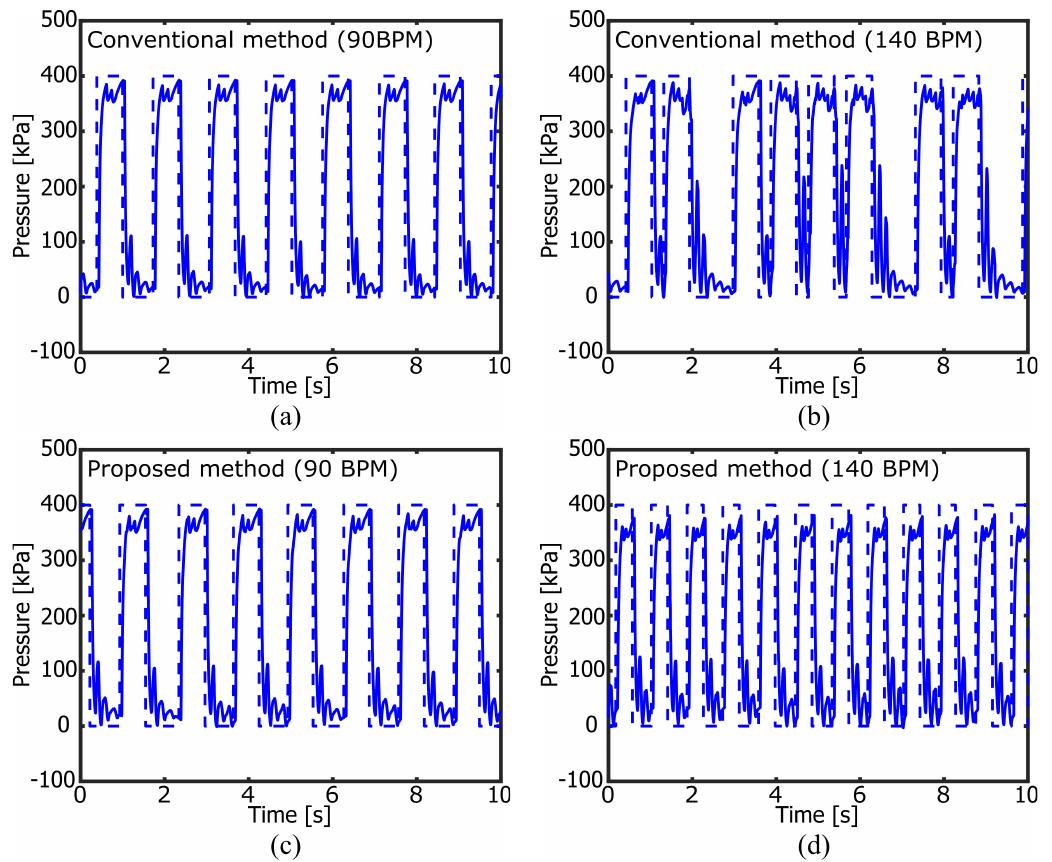
Figure 15. RCF PARM pressure trajectories of the 90 and 140 BPM walking. The horizontal axis is time (s), and the vertical axis is pressure (kPa). The solid and dashed lines are the measured pressure and the reference pressure. ( a ) 90 BPM walking using the conventional method. ( b ) 140 BPM walking using the conventional method. ( c ) 90 BPM walking using the proposed method. ( d ) 140 BPM